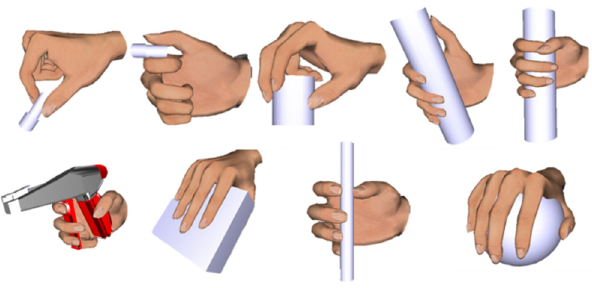
Figure 5. The implemented grip types of the grip type recognition system.